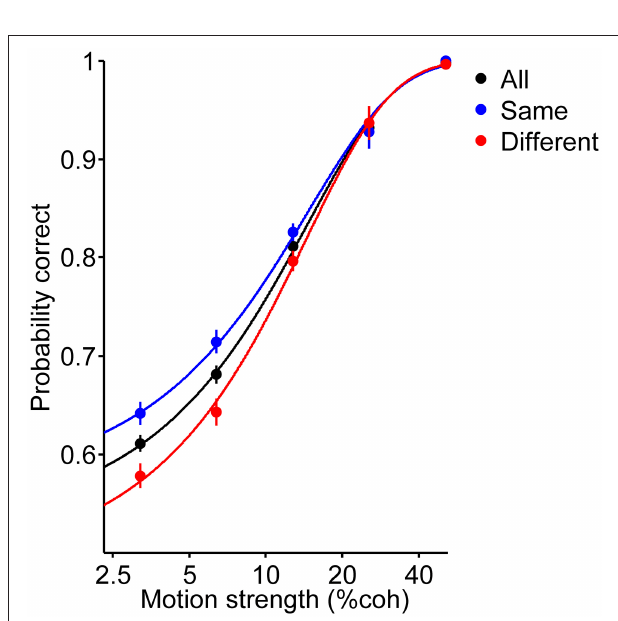
FIGURE 3 | Psychometric function of the current trials. Red and blue data points depict performance of participants for the different and same decision conditions, respectively. Black data points are pooled from these two conditions. Curves are the fit of the logistic regression to the data (Equation 1 for black curve and Equation 2 for red and blue curves). Error bars indicate SE (Standard